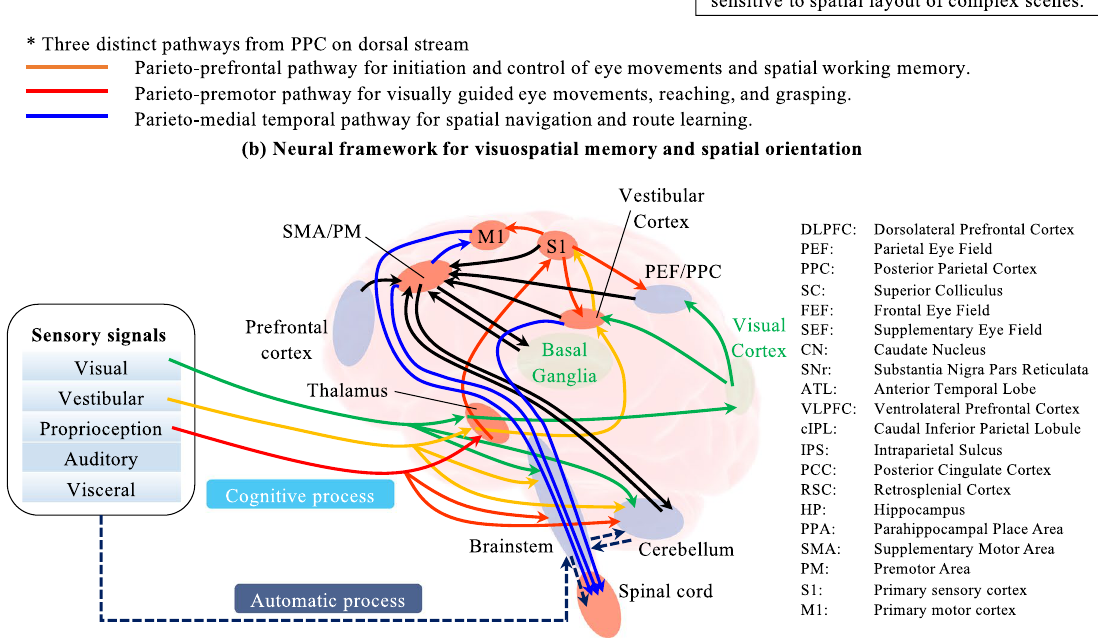
Figure 1. Neural pathways activated in three different activities. ( a ) Anti-saccade task activates the frontal lobe more, whereas pro-saccade task elicits rather the posterior parietal cortex. ( b ) The parieto-prefrontal pathway is used for visuospatial memory, while the parieto-medial temporal pathway is activated in spatial orientation. ( c ) The frontal lobe and parietal cortex are active in cognitive processing of postural